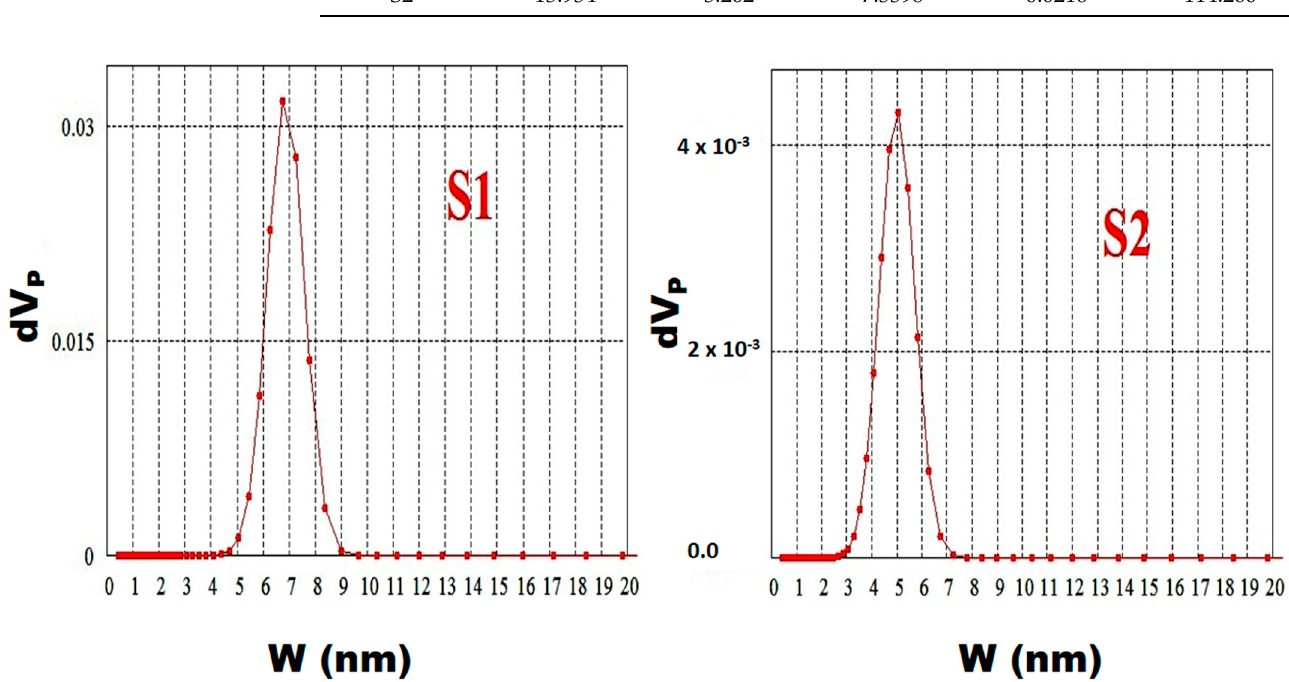
Figure 5. Pore-size distribution of S1 and S2